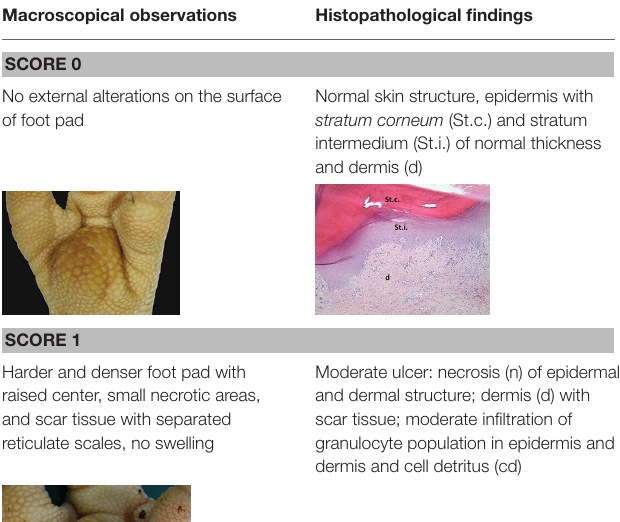
TABLE 3 | Examples of macroscopic and histological observations of foot pads with different levels of foot pad lesions. Macroscopical